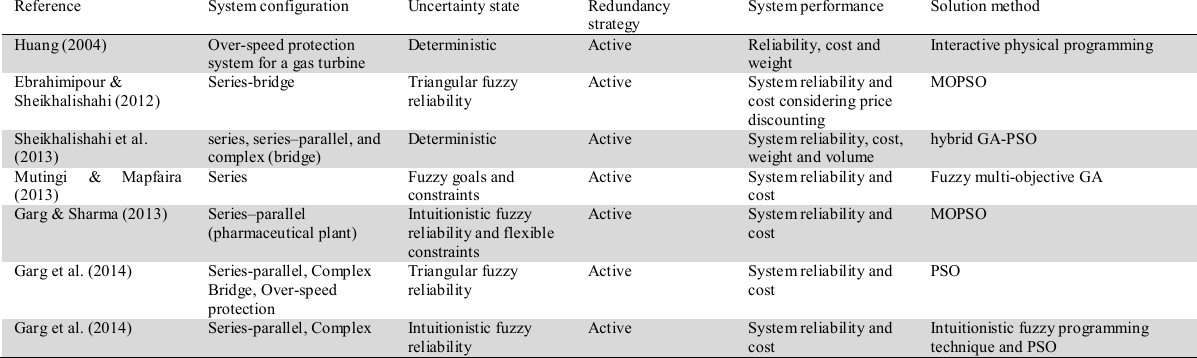
Reliability- Redundancy Allocation (Multi Objective